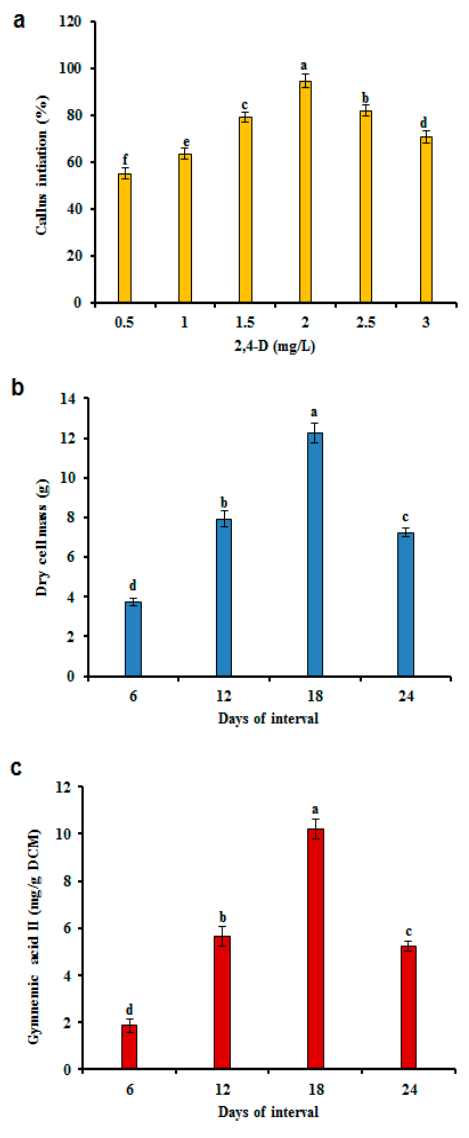
Figure 1. Callus induction and biomass accumulation in Gymnema sylvestre . ( a ) E ff ect of di ff erent concentrations of 2,4-dichlorophenoxyacetic acid (2,4-D) in combination with 0.1 mg / L kinetin (KIN) for callus induction in G. sylvestre . ( b ) Biomass accumulation. ( c ) Gymnemic Acid II (GA II) production on MS liquid medium with 2,4-D (2 mg / L), KIN (0.1 mg / L), and sucrose (30 g / L) with time. Di ff erent letters indicate a significant di ff erence at p ≤